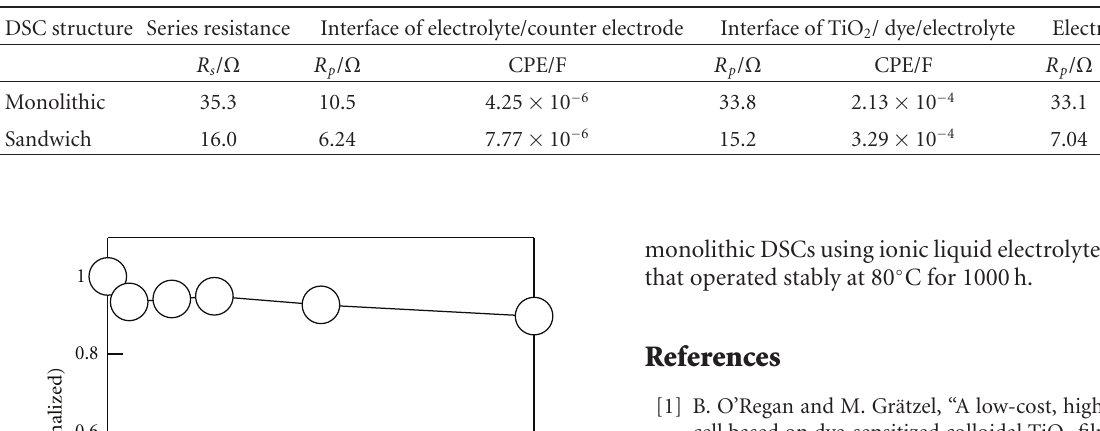
Table 1: Impedance elements (resistance and constant-phase element) in monolithic- and sandwich-structured DSCs under photoirradiated open-circuit conditions.